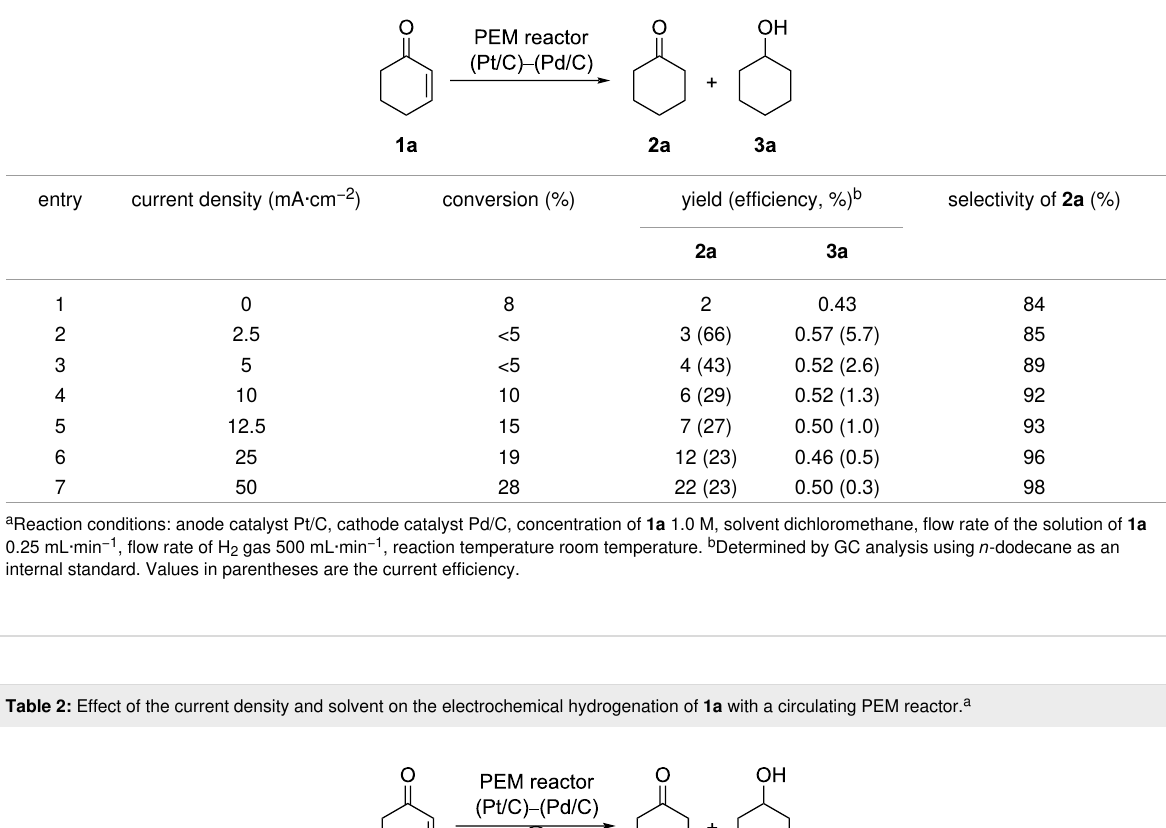
Table 1: Effect of the current density on the electrochemical hydrogenation of 1a with a PEM reactor (a single path). a